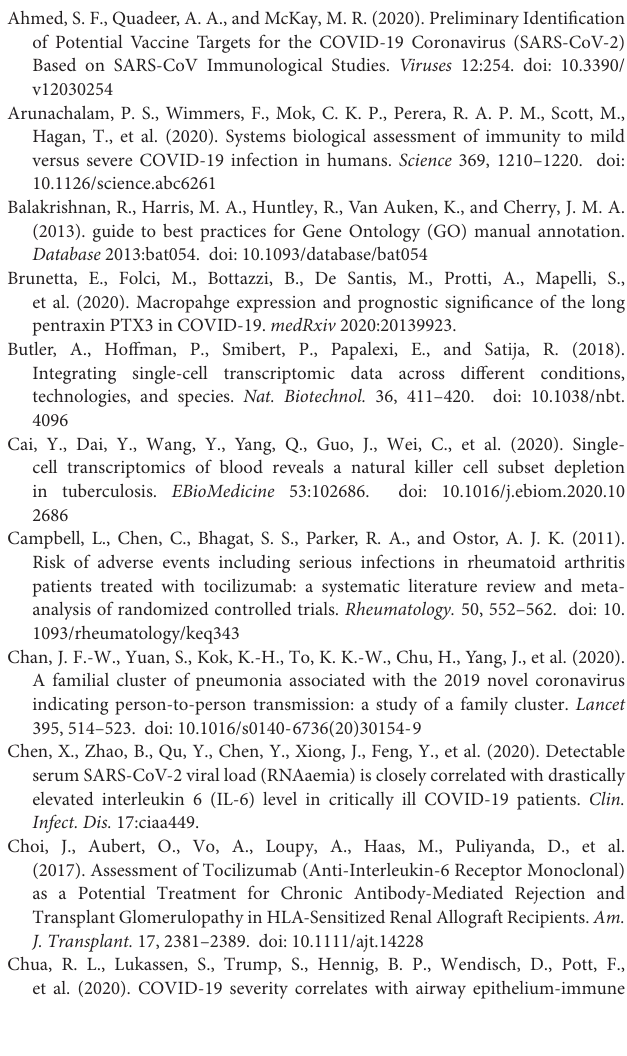
Supplementary Figure 5 | Gene ontology biological processes enrichment. (A) Enriched biological processes based on the Gene Ontology database for CD4 + T cells. (B) Enriched biological processes based on the Gene Ontology database for CD8 + T cells. (C) Enriched biological processes based on the Gene Ontology database for monocytes. Legend shows color gradient for adjusted p -values, with red being smaller adjusted p -values and blue being larger adjusted p -values. The x -axis represents the number of genes from the gene list that were a part of that respective biological process pathway. Supplementary Figure 6 | Heatmaps of COVID-19 and healthy patient gene expression. (A) Unsupervised hierarchical clustering of gene expression data from bulk RNA-seq of COVID-19 infected and healthy patient PBMCs, using only upregulated genes from control monocytes from our single-cell study; near perfect clustering is seen between COVID-19 and healthy patients; additional phenotypes included are patient sex and disease severity. (B) Unsupervised hierarchical clustering of gene expression data from bulk RNA-seq of COVID-19 infected and healthy patient monocytes, using only upregulated genes from control monocytes from our single-cell study; perfect clustering is seen between COVID-19 and healthy patients; relative gene expression is represented as a color gradient with higher gene expression represented in red and lower gene expression represented as